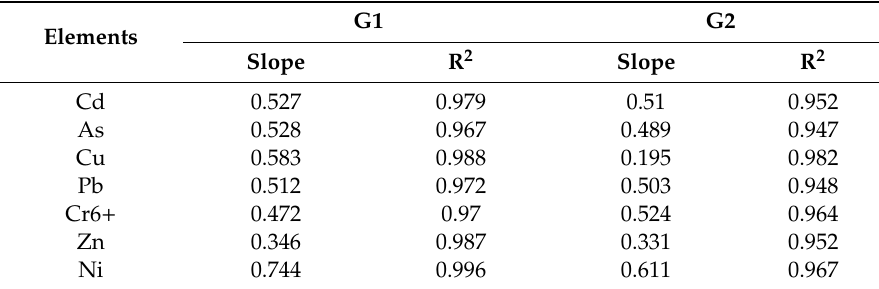
Table 4. Release mechanism of HMs from G1 and G2.